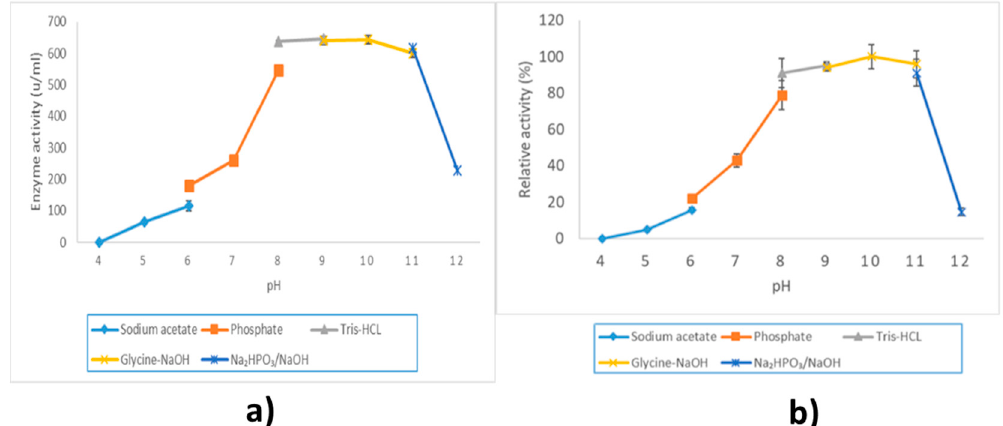
8 of 21 Figure 6. Effect of temperature on LIP2 lipase. ( a ) Effect of temperature on lipase activity. The li- pase assay was tested at different temperatures (10–80 °C). ( b ) The effect of temperature on lipase stability. The enzyme was pre-incubated beforehand at various temperatures (10–80 °C) in 30 min. The relative activity was calculated based on the percentage of the highest activity. Error bars indi- cate standard deviation of means ( n = 3). Absence of bar indicates that errors were smaller than the symbols and lines. 2.7.2. Effect of pH on Lipase Activity and Stability LIP2 lipase was active from pH 6.0 until pH 11.0, while the optimum pH for the ac- tivity was at pH 9.0 in Tris-HCL buffer (Figure 7a). Even so, LIP2 was capable of retaining more than 75% of its maximum activity in an alkaline condition value range from pH 8.0